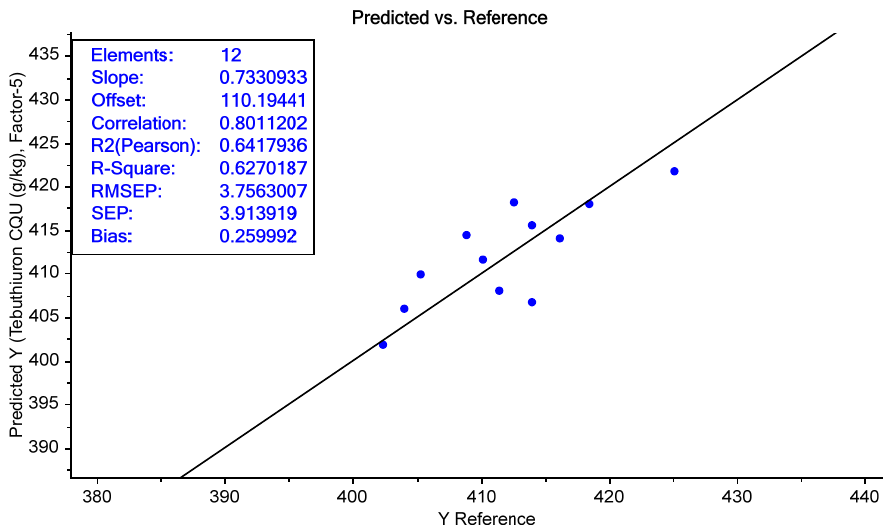
Figure 24. The predicted vs. measured tebuthiuron content of the Regain 400 samples in the independent test set ( n =12).